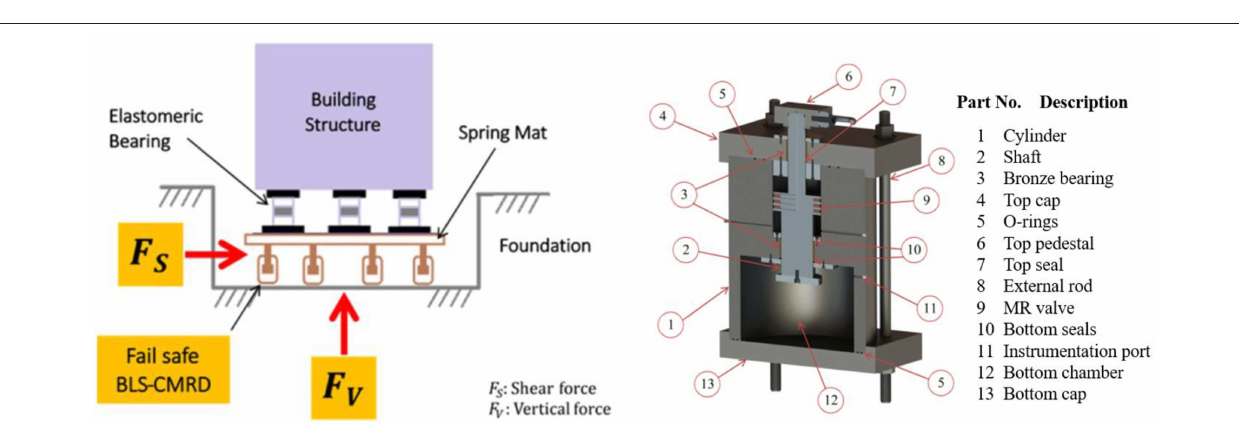
FIGURE 5 | The installation of the liquid spring–magnetorheological damper in structure and its cutout view (Cesmeci et al.,